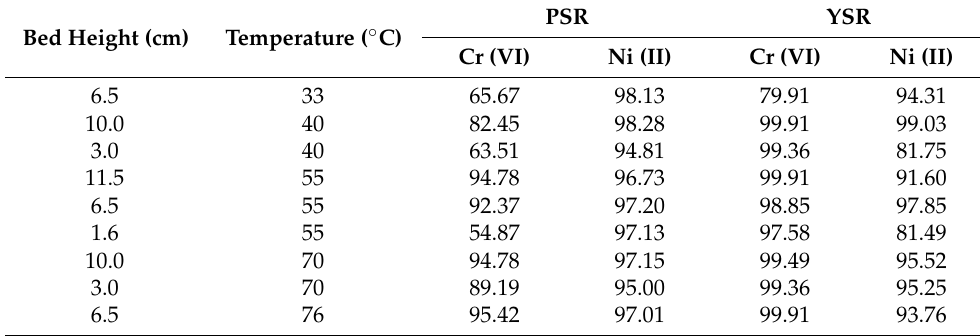
Table 10. Removal efficiencies of Cr (VI) and Ni (II) on PSR and YSR in a continuous system.